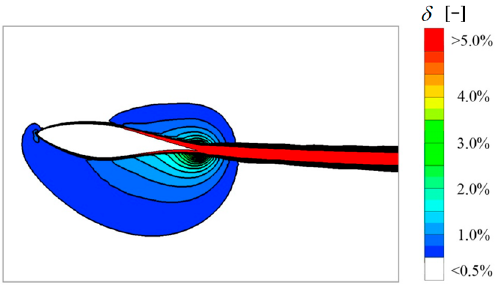
Figure 4. Contours of dimensionless-induced velocity: ( a ) Induced by the airfoil entity,